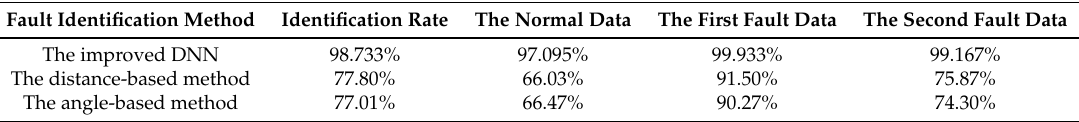
Table 2. The identification rates of various methods.